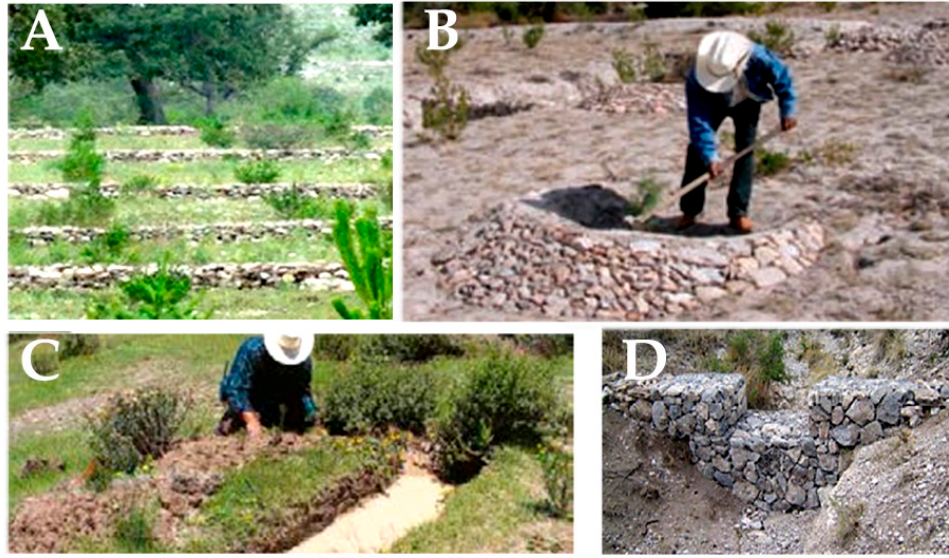
Figure 6. Preparing terraces for reforestation. ( A ) stone barriers, ( B ) water catchment, ( C ) trench ditches, and ( D ) filter dam [47].